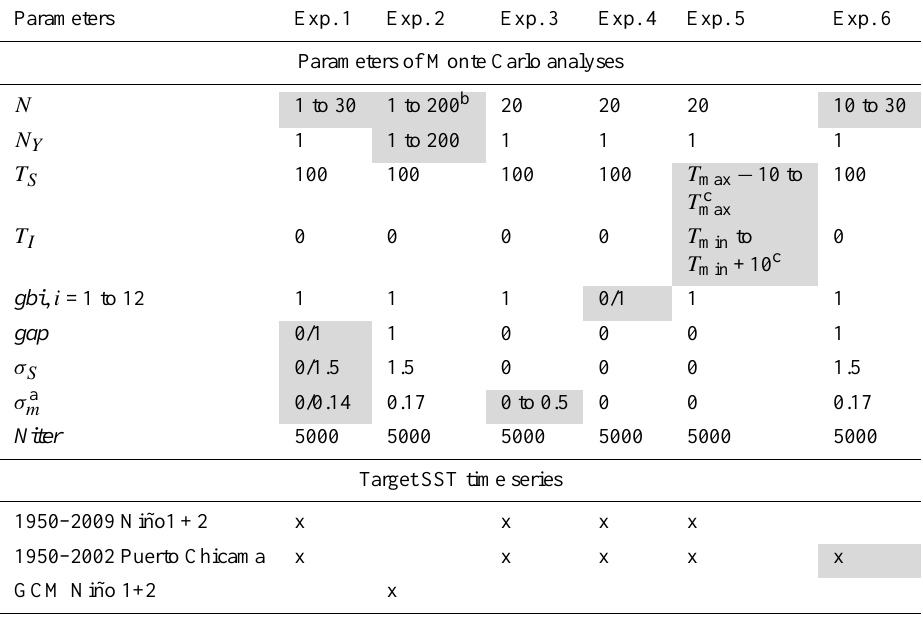
Table 3. Parameter setting in sensitivity experiments 1 to 5. Gray cells indicate varying parameters. Parameters Exp. 1